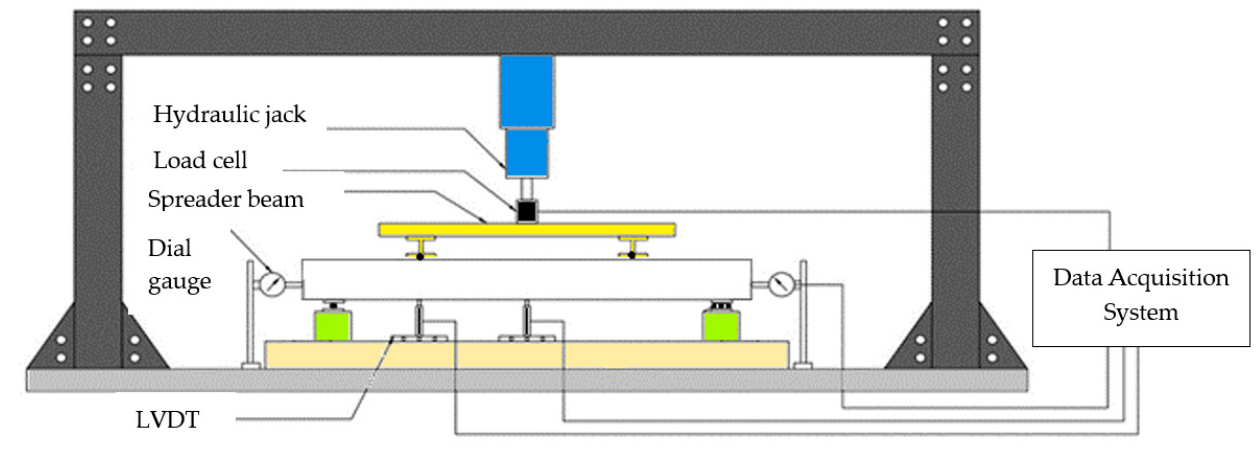
Figure 9. Schematic view.